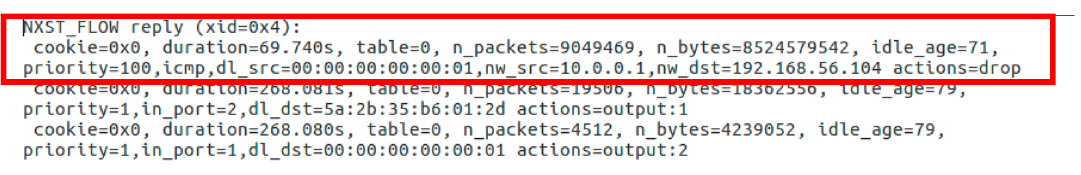
Figure 17. Scenario III Test OpenFlow Switch’s Flow Table after DDoS Attack.